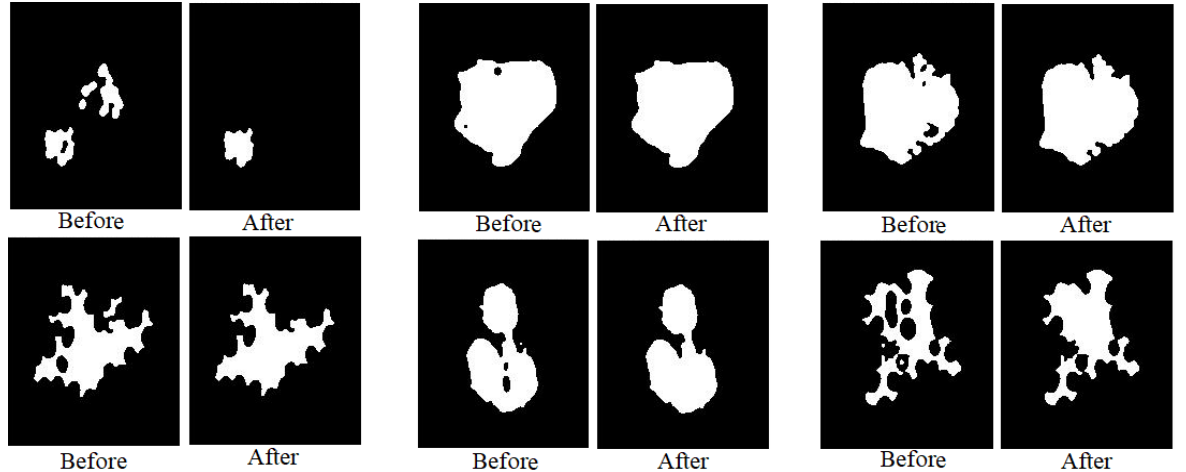
Figure 5. Samples from the two datasets before and after the morphological